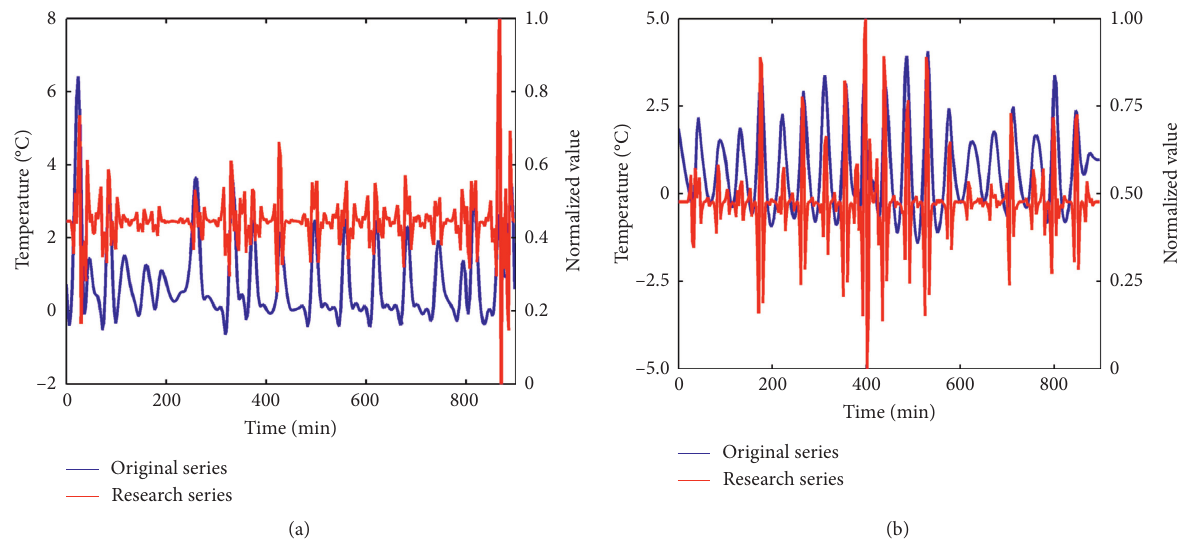
Figure 6: Wavelet transform for temperature increment series of ore samples: (a) sample A; (b) sample B.